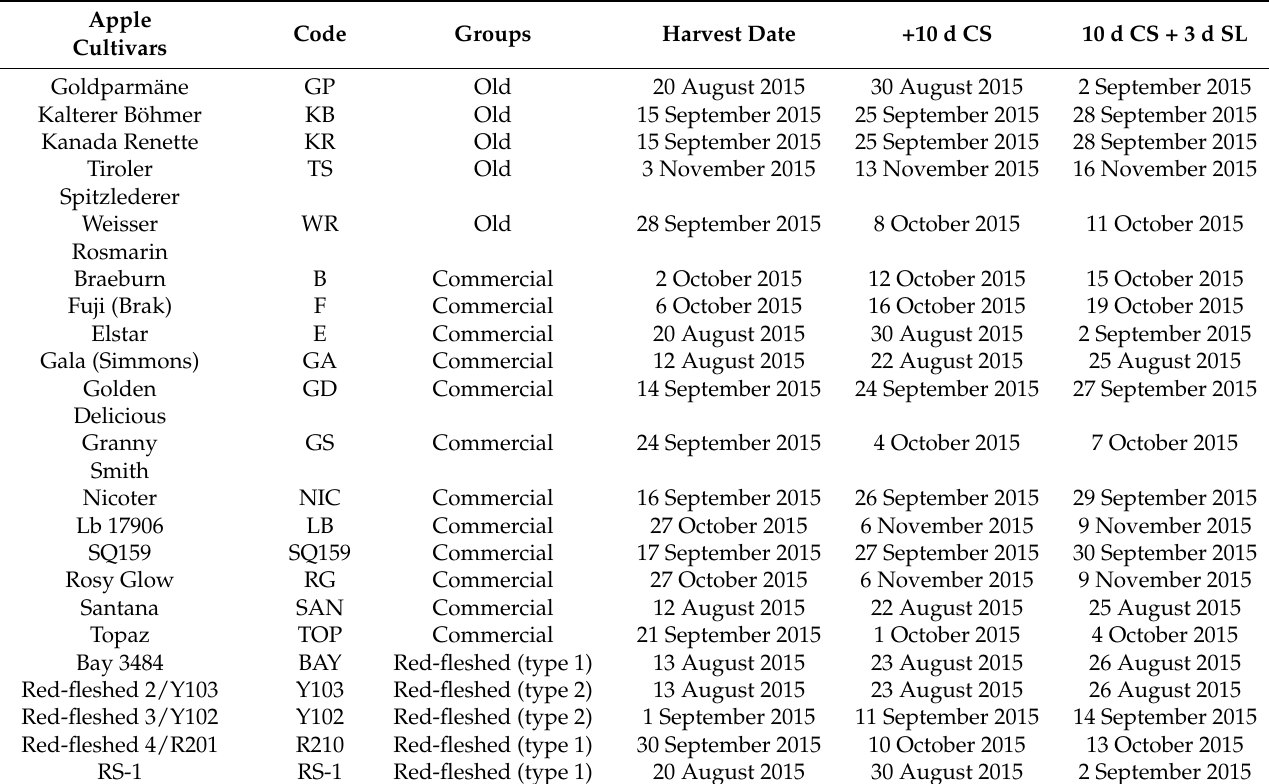
Table 1. List of cultivars, code of cultivars, variety group, harvest days, storage days, and sampling days of apples analyzed in this study (d = day, CS = cold storage, SL = shelf